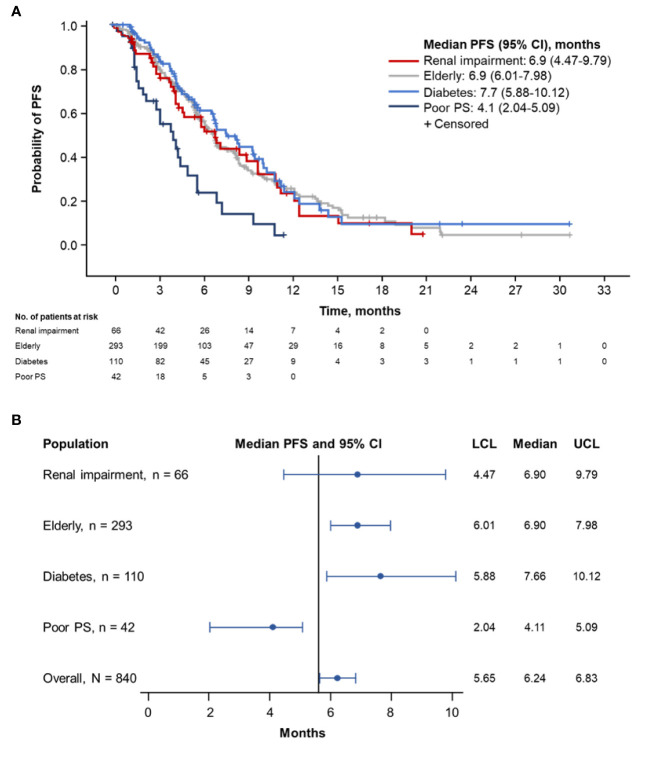
Kaplan-Meier curve (A) and forest plot (B) of PFS by population. PFS, progression-free survival; PS, performance status; LCL, lower confidence limit; UCL, upper confidence limit.